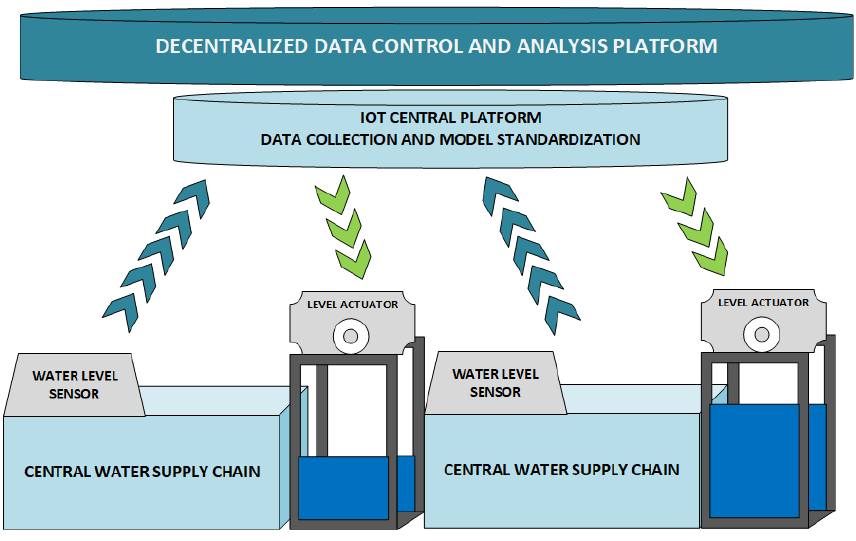
Figure 3. Water level management